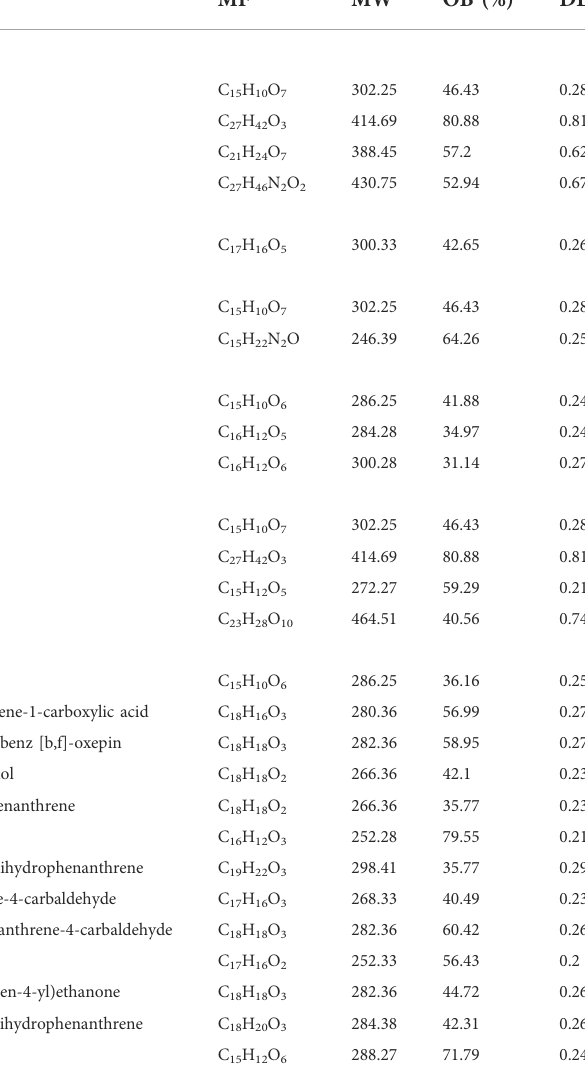
TABLE 1 Bioactive compounds retrieved from TCMSP.